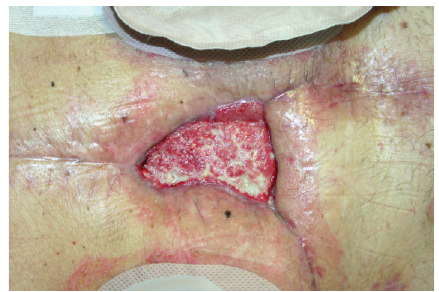
Figure 3: Abdominal dehiscence after 28 days of NPWT.